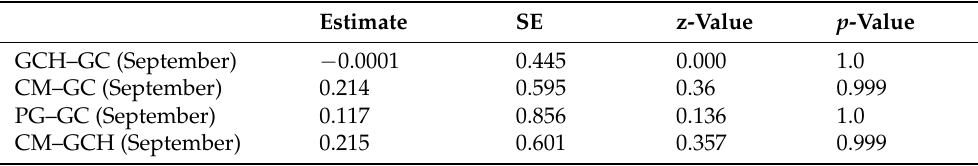
Table A11. Differences in activity densities of herbivore carabid beetles, comparing grass–clover (GC) and grass–clover herbs (GCH) with each other, and in comparison to conventional maize (CM) and permanent grasslands (PG) in May/June and September. p -values are indicated as * p <